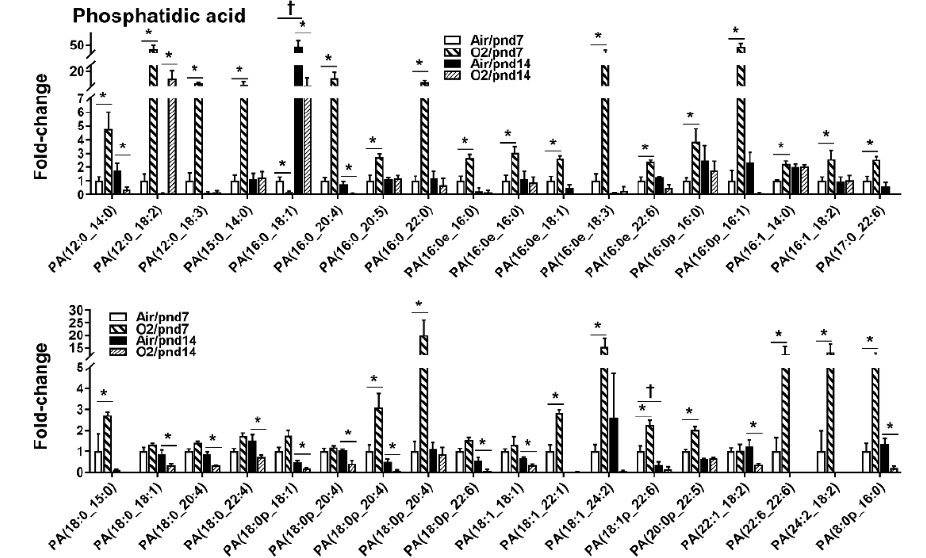
Figure 2. Compositional changes of lung PA species in mice exposed to hyperoxia as neonates. PA species in mouse lungs with 2-fold change and p < 0.05 between air and hyperoxia groups at pnd7 and pnd14 were listed. n = 6. * p < 0.05 vs. corresponding air; † p < 0.05 vs. air/pnd7 .